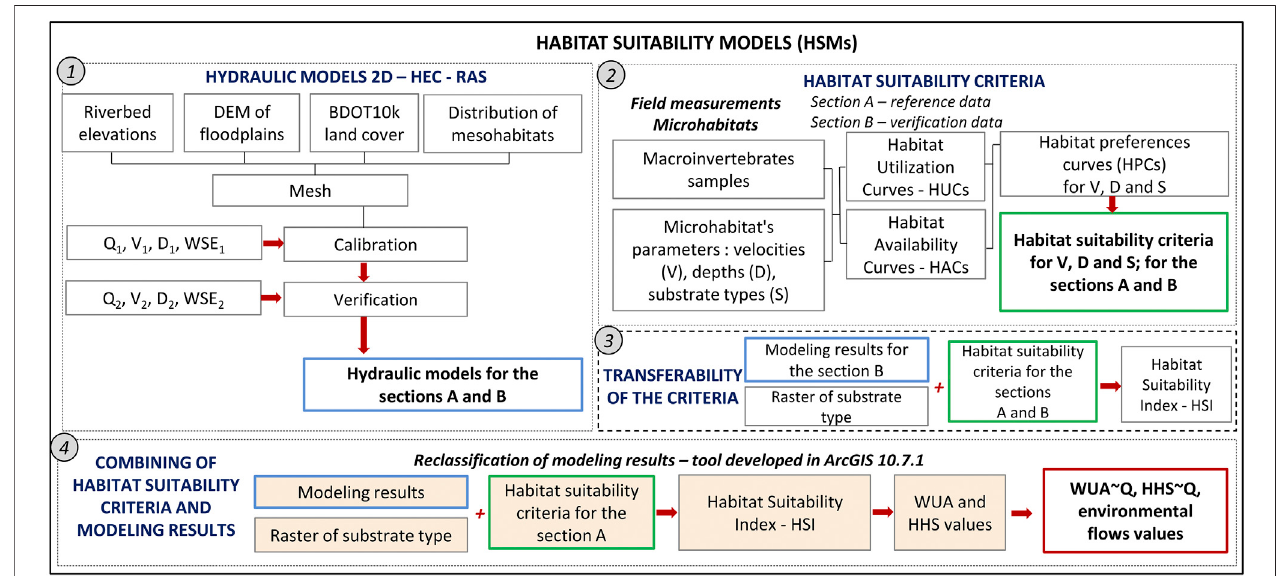
FIGURE2| DiagramshowingtheconstructionoftheHSMsdevelopedinthestudy.V — fl owvelocities,D — depths,andWSE — watersurfaceelevations,measured at two different fl ow rates Q 1 and Q 2